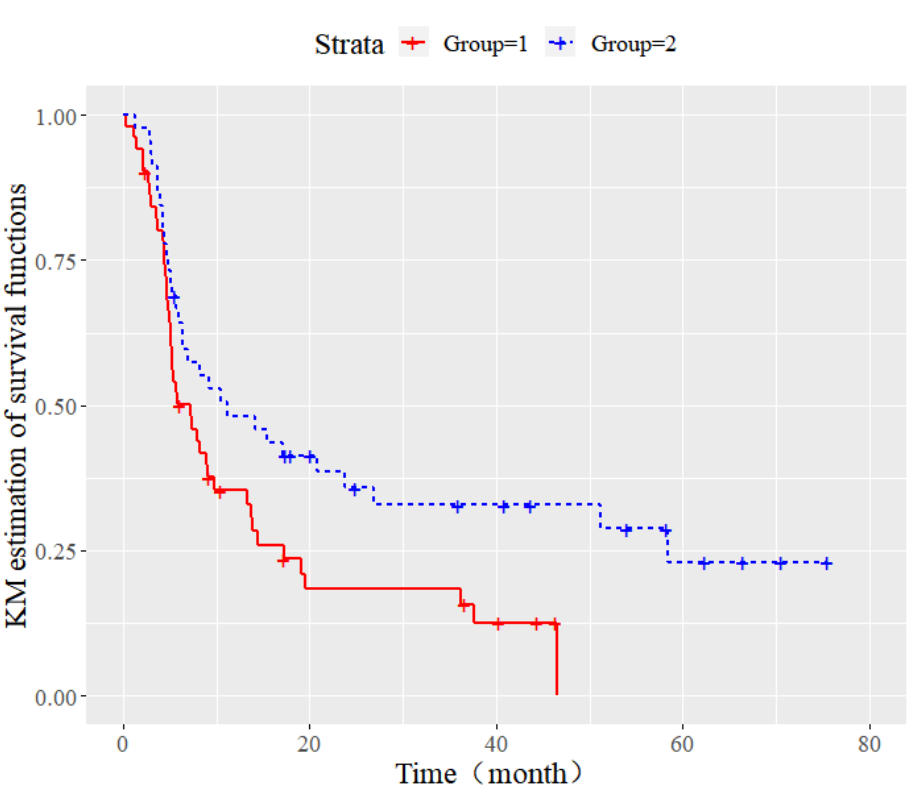
Figure 7. Kaplan–Meier curves of head-and-neck-cancer patients survival time.